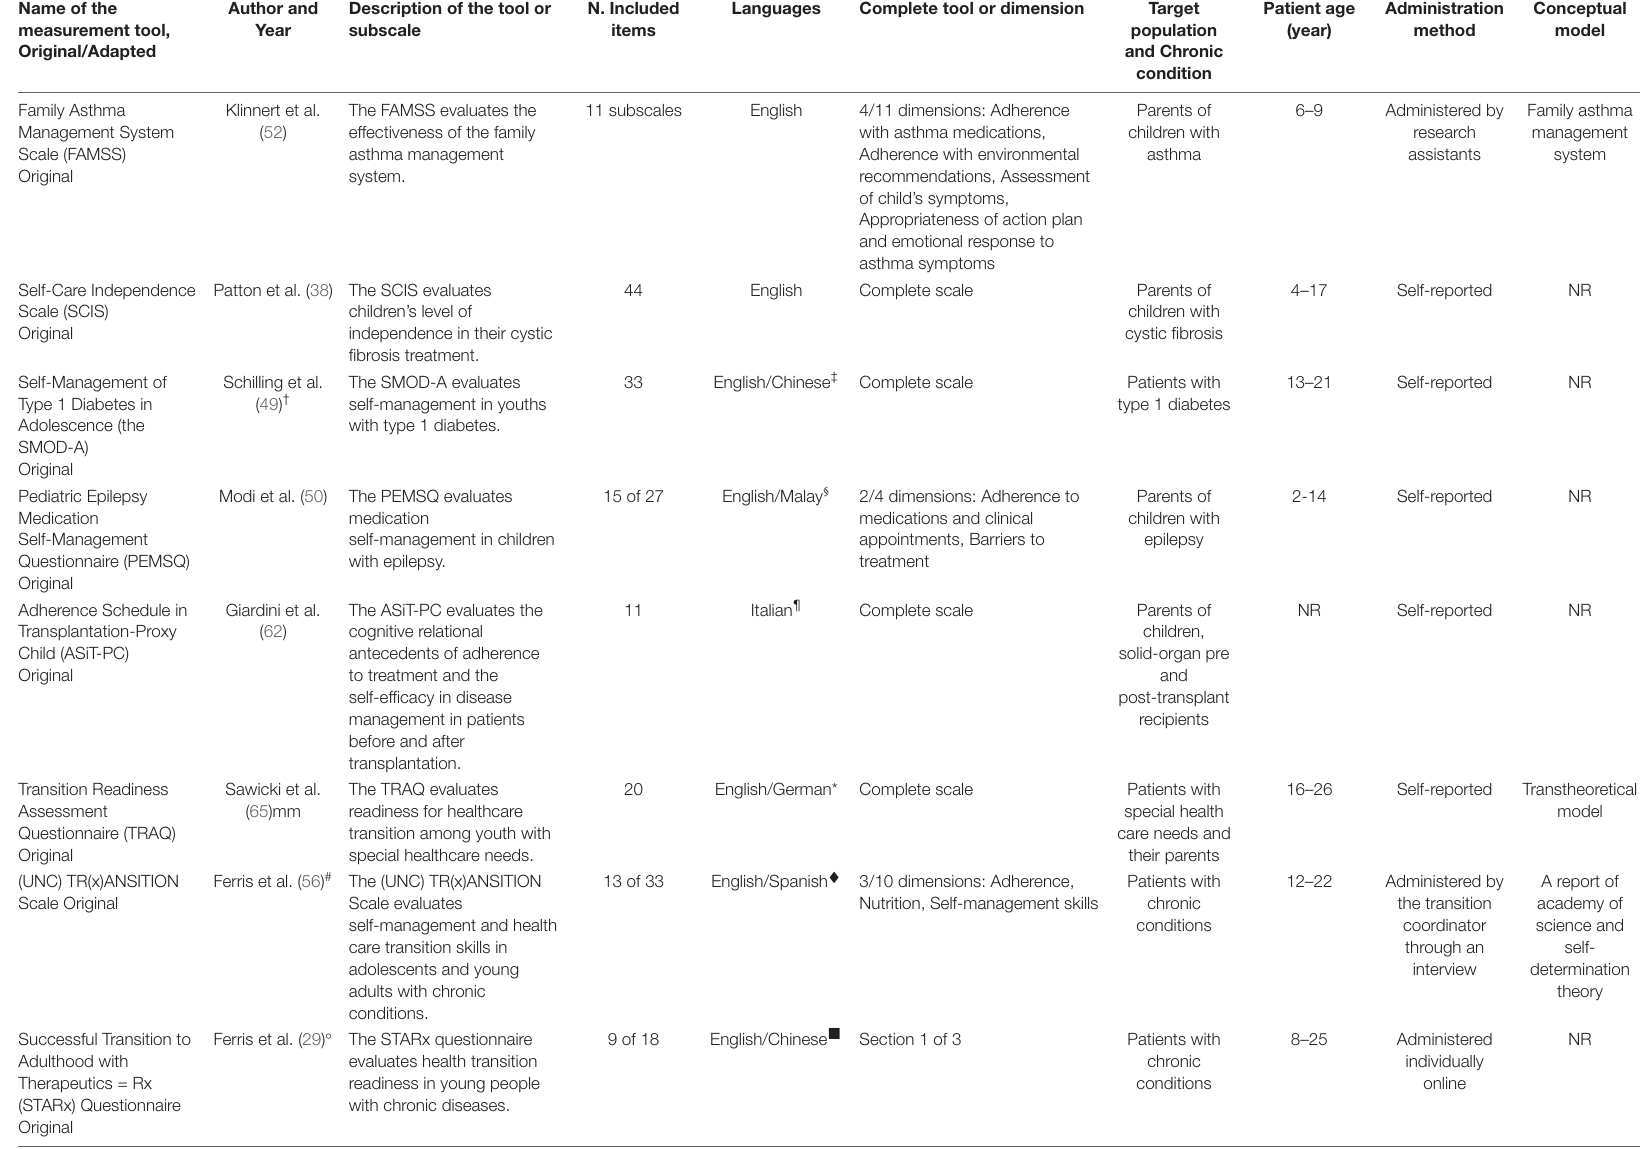
TABLE 2 | Characteristics of the self-care measurement tools retrieved from this review. Name of the measurement